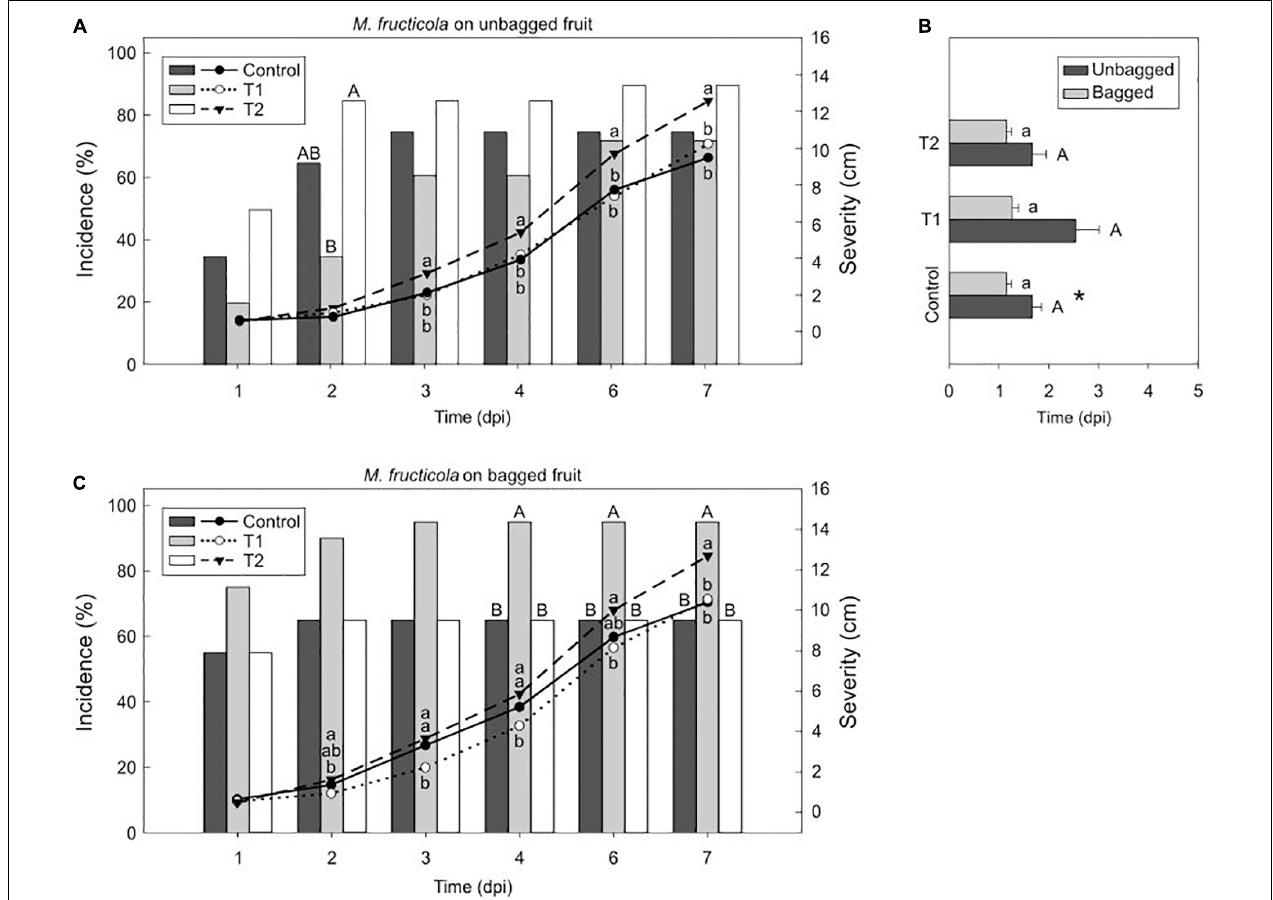
FIGURE 4 | Light effect on the M. fructicola -nectarine interaction. Incidence (% of brown rot, bars) and severity (lesion diameter length in cm of rotted fruit, lines) of M. fructicola in unbagged (A) and bagged (C) “Fantasia” nectarines along the infection time course (dpi, days post-inoculation) incubated for 7 days under treatments 1 and 2 and control condition (constant darkness). Bars represent the mean of incidence on fruits ( n = 20). Lines represent the mean of diameter length of rotted fruit. Different uppercase and lowercase letters indicate significant differences ( P ≤ 0.05) of incidence and severity, respectively, among incubation conditions according to orthogonal contrasts at each time point. No letters indicate no significant differences. The incubation period (dpi) of M. fructicola in bagged and unbagged “Fantasia” nectarines (B) after 7 days of incubation under treatments 1 and 2 and control condition. Bars represent the mean of fruits with symptoms ( n = 2 to 20) and error bars represent the standard error of the means. Different uppercase and lowercase letters indicate significant differences ( P ≤ 0.05) among incubation conditions in unbagged and bagged fruit, respectively, according to orthogonal contrasts. Symbol (*) indicates significant differences between bagging conditions under control condition according to Student’s T -test ( P ≤